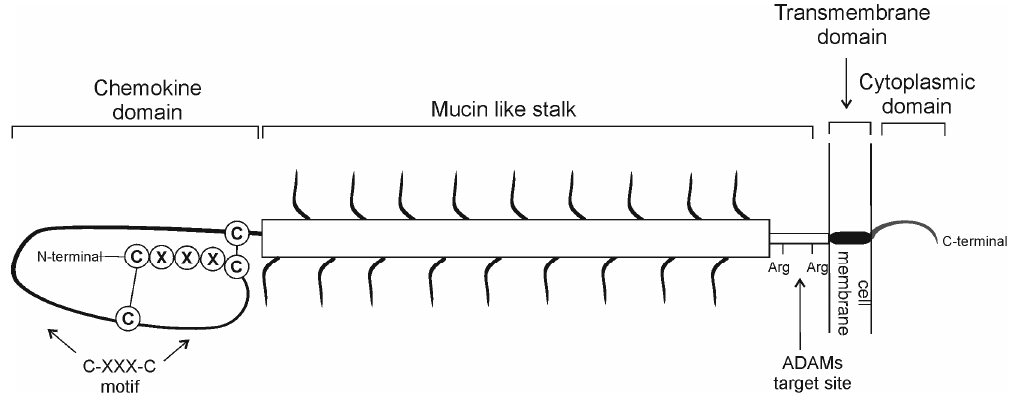
Figure 1. Schematic of the fractalkine (CX3CL1) structure. Fractalkine is expressed as a membrane- Figure1. Schematicofthefractalkine(CX3CL1)structure.Fractalkineisexpressedasamembrane-bound molecule with a chemokine domain, a heavily glycosylated mucin stalk-like domain attached via a transmembrane domain to the cell surface and a short cytoplasmic domain. Cleavage of CX3CL1 is mediated under physiological and pathological conditions by the proteases ADAM10 and